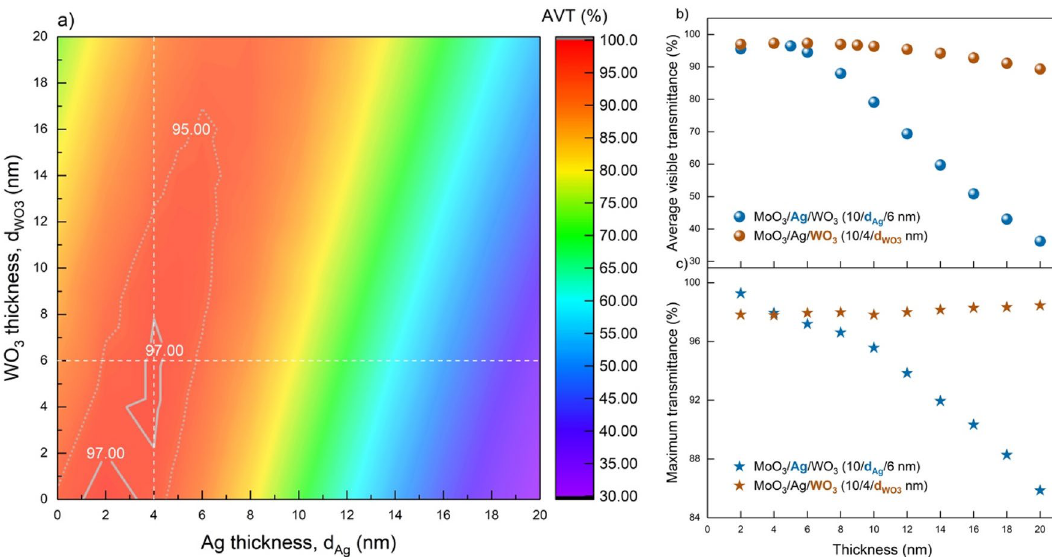
Figure 2. Variation of AVT and transparency depending on the thickness of the transparent contact structure. ( a ) Mapping the AVT variation of the structure according to d Ag and d WO 3 values for MoO 3 /Ag/WO 3 (10/ d Ag / d WO 3 nm). ( b ) AVT and, ( c ) T max values for structures of 10/4/ d WO 3 nm and 10/ d Ag /6 nm. Areas with solid grey lines and grey dashed lines have AVTs greater than 97% and 95%, respectively. The point where the white horizontal and vertical lines intersect gives the maximum AVT. It should be noted here that Ag is a determining layer for both AVT and maximum transparency, and outer dielectric WO 3 acts as a waveguide. The encircling effect on the electromagnetic wave of WO 3 causes an increment in maximum transparency with the increase of d WO 3 . Even the d Ag and d WO 3 values of 20 nm, AVT is greater than 25% which is the lower limit for window applications.